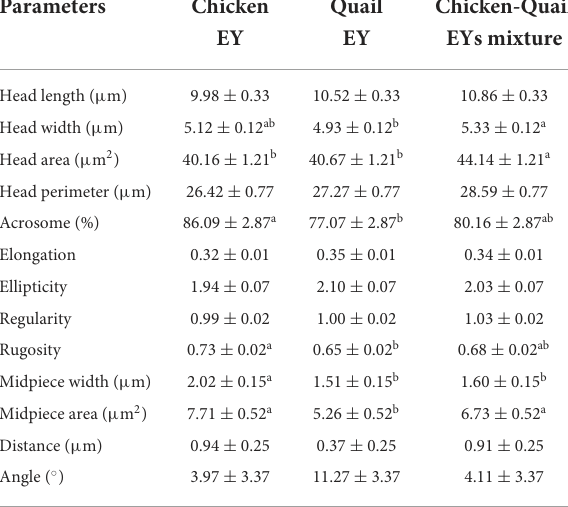
TABLE 1 Effects of adding and combining egg yolks (EY) of chicken and/or quail to the Tris glycerol extender on motility, vitality, plasma membrane integrity, DNA integrity and abnormalities of ram sperm before freezing.